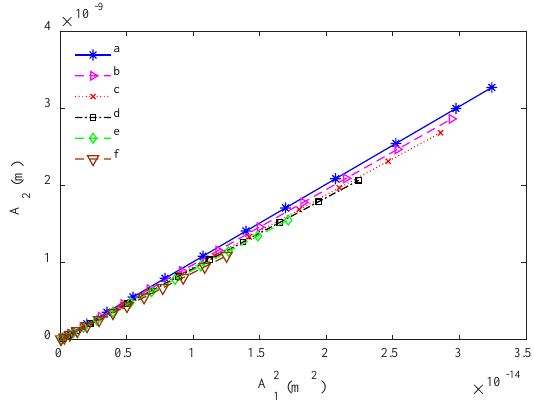
Figure 7. The slopes of A 2 /A 12 for different specimens. Table 3. Nonlinear parameters for different specimens before and after corrections.